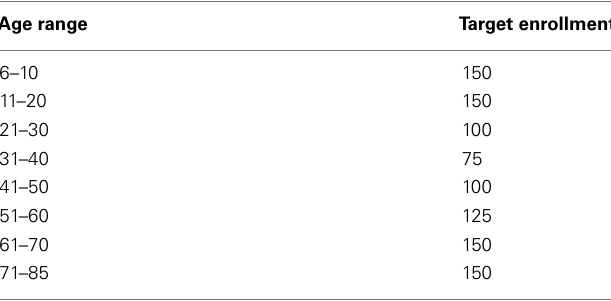
Table 2 | Enrollment strategy for enhanced